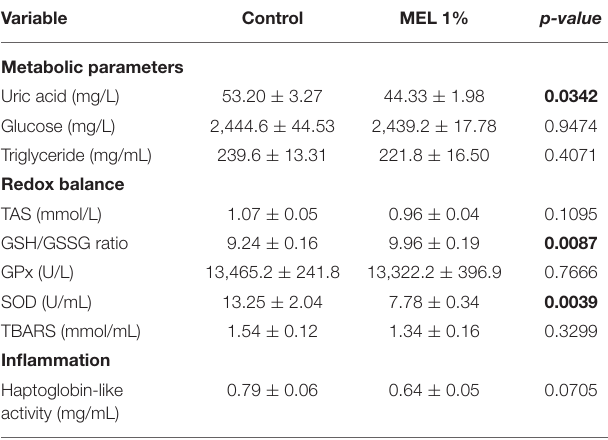
TABLE 7 | Effects of MEL extract supplementation on physiological parameters of chicken blood at D34. Variable